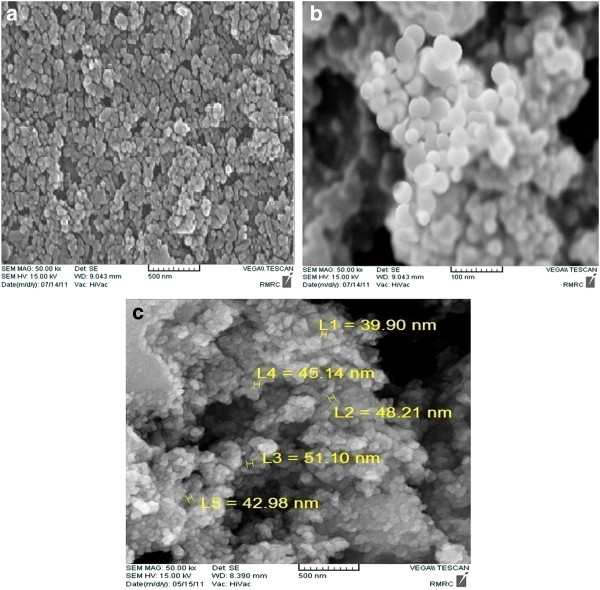
The SEM micrographs of (a) pure Fe3O4 nanoparticles (b) Fe3O4 nanoparticles grafted by poly-(NIPAAm-MMA) (c) Hydrodynamic sizes of PNIPAAm-MAA-grafted MNPs.